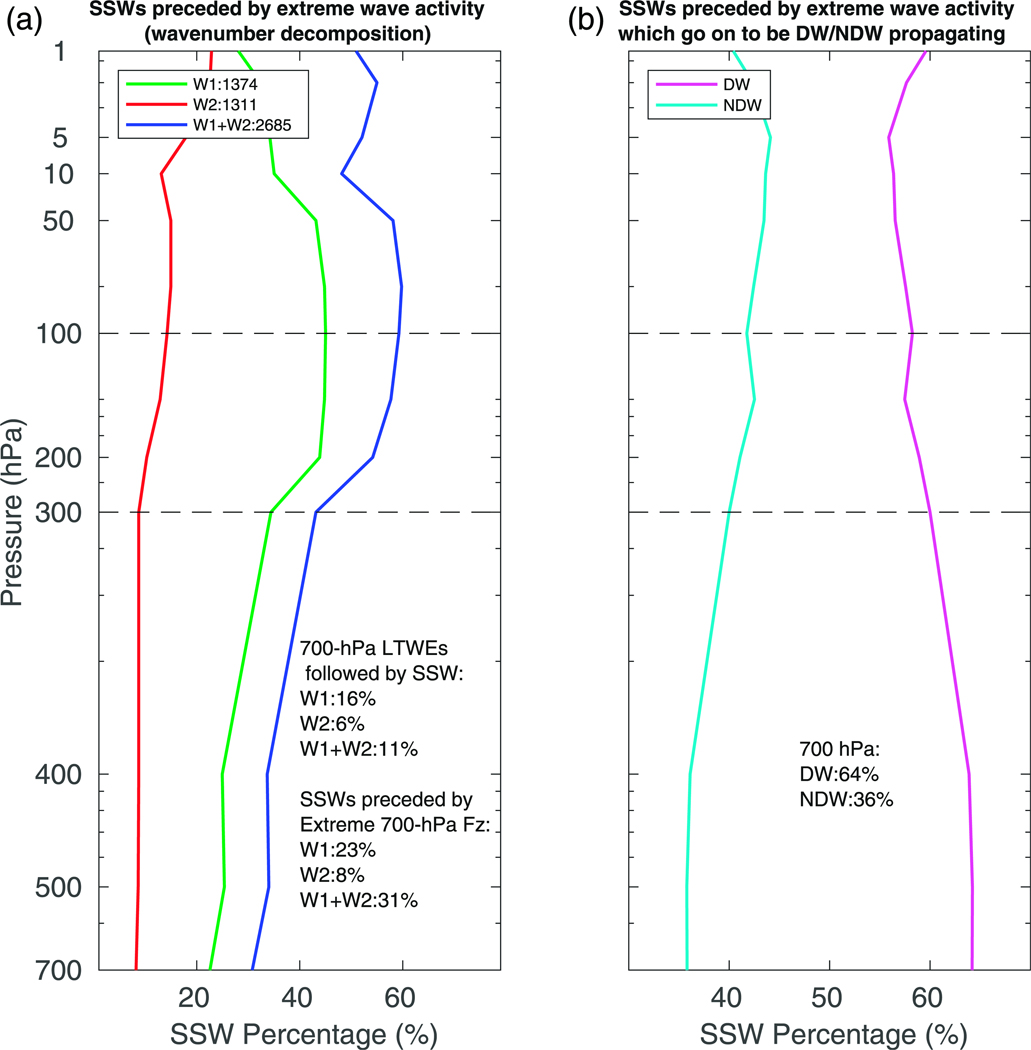
Line plots of (a) the percentage of SSWs that are preceded by extreme (>two standard deviations) F(z) at each level for wave 1 (green), wave 2 (red), and waves 1 and 2 combined (blue), and (b) the percentages of SSWs that are preceded by extreme wave activity at each level that go on to be DW (magenta) or NDW (cyan) propagating. Inset in (a) are the numbers and percentages of SSWs (rounded to the nearest percent) preceded by lower-tropospheric wave events (LTWEs; 700 hPa) to be compared with Birner and Albers (2017), as well as the numbers of extreme wave-activity events that are followed by an SSW event.